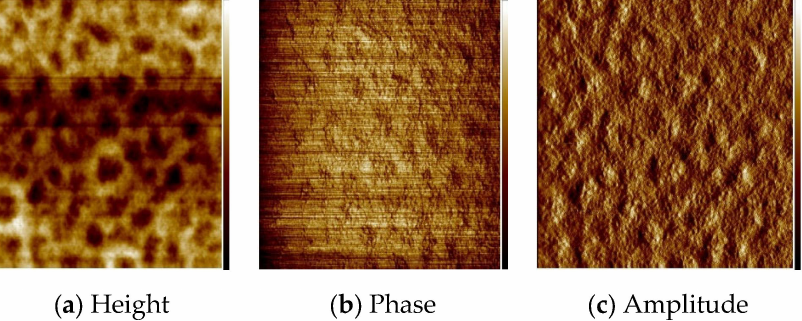
Figure 14. AFM of L1 /Si, R a = 1.32 nm, R q = 1.78 nm, thermal vapor deposition, scan size 5 µ m.